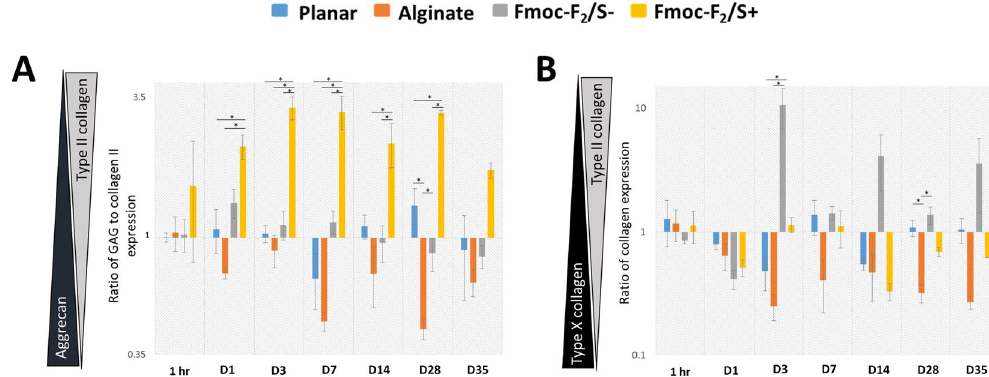
Figure 4. Comparison of chondrocyte expression of pericyte cells differentiated over a 5 week period using 15.5 kPa Fmoc-F 2 /S hydrogels in the presence ( + ) and absence ( − ) of chondrogenic induction media. Cells were also differentiated using alginate hydrogels and chondrogenic induction media. ( A ) Expression of type II collagen relative to aggrecan showed higher type II collagen transcription for cells cultured in Fmoc-F 2 /S + hydrogels. ( B ) Expression of type II collagen relative to type X collagen. Gene expression was compared against pericytes cultured on glass cover slips (undifferentiated on planar substrate) as a negative control. Error bars are standard error of the mean; * indicate significant difference between groups as determined by one-way ANOVA followed by Bonferroni post hoc test where p < 0.05; n =